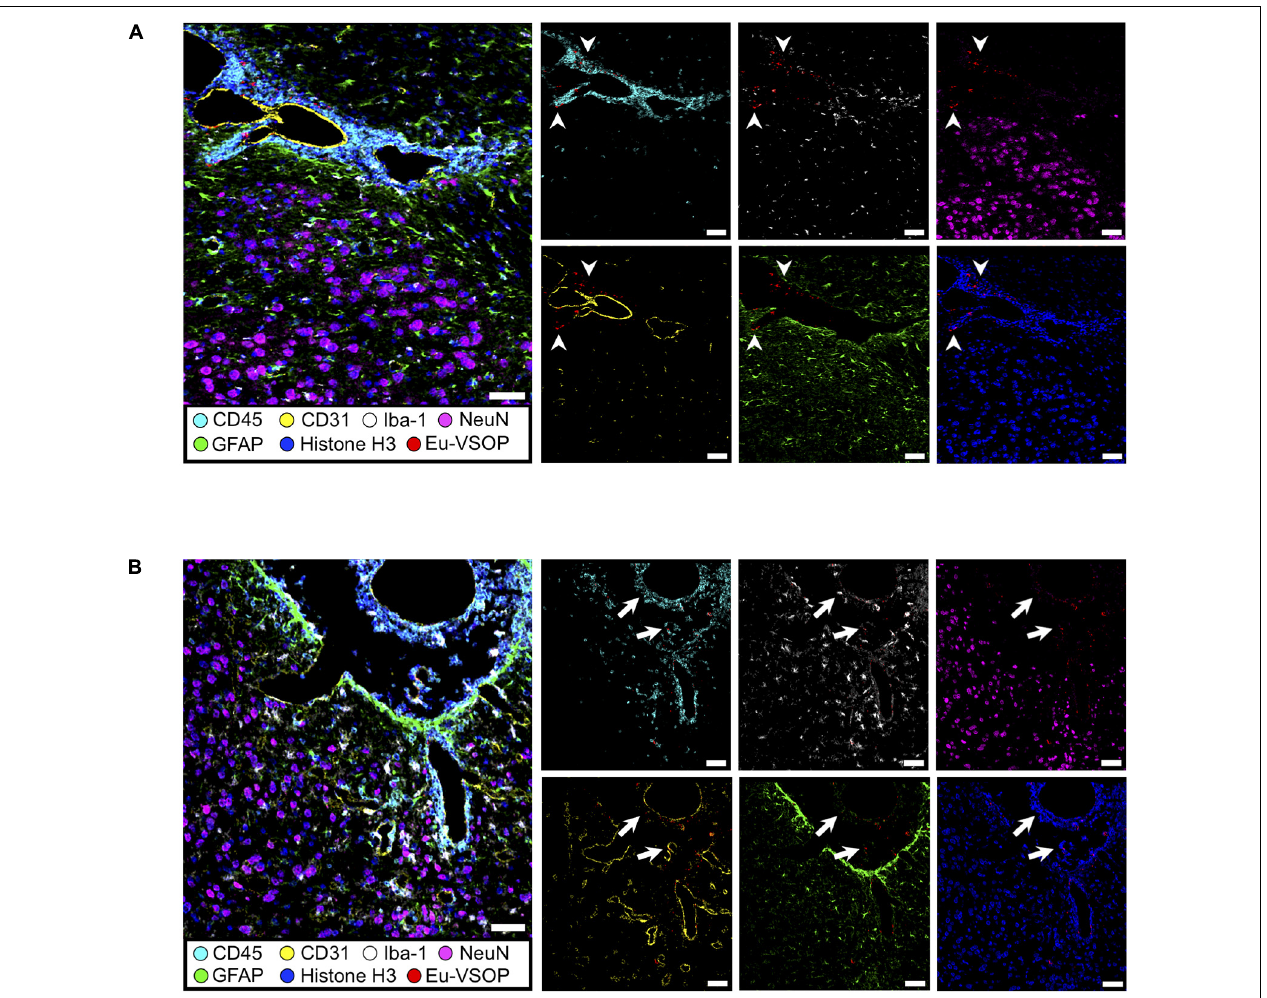
FIGURE 9 | Histological visualization of Eu-VSOP distribution by IMC. (A) Magnetic particle accumulation in the perivascular space with strong leukocyte infiltrate (arrowheads) located between brain stem and hippocampal formation. (B) In the third ventricle, particles can be found in the choroid plexus and are associated with perivascular inflammation (arrows). Eu-VSOPs (red dots), neurons (NeuN—magenta), astrocytes (GFAP—green), endothelial cells (CD31—yellow), nuclei (histone H3—blue), microglia (Iba-1—white), leucocytes (CD45—cyan). Scale bar: 50